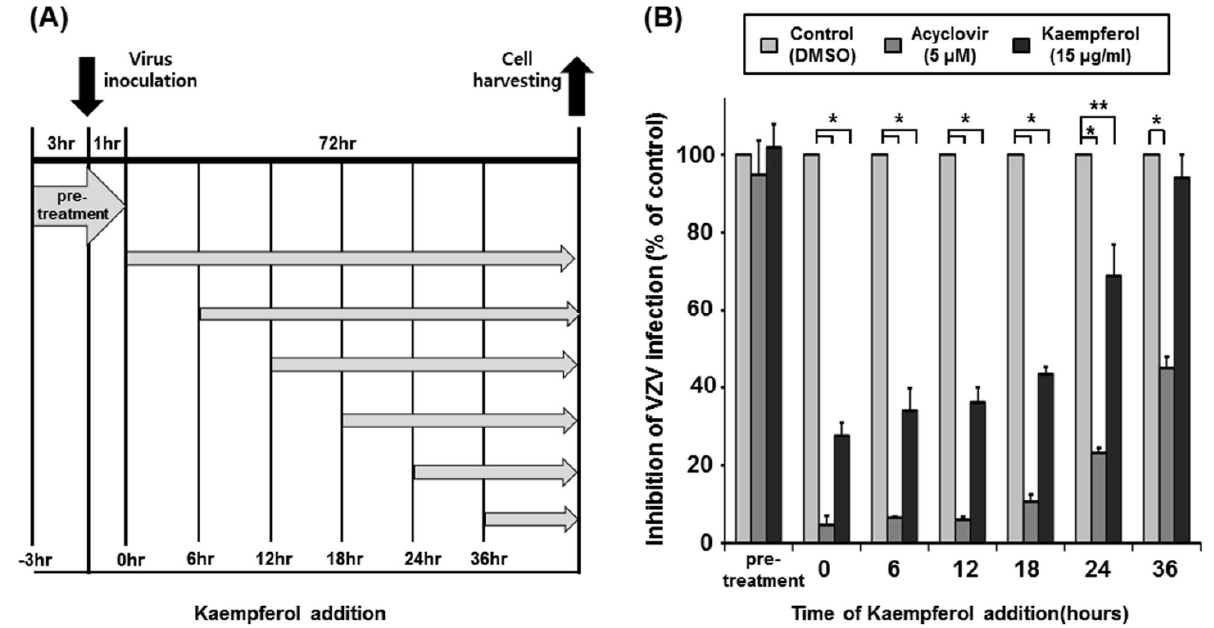
Figure 4. Time-of-drug-addition assay to identify the target of kaempferol. ( A ) Schematic diagram of the assay. ( B ) HFFs were pre-treated with kaempferol, acyclovir, or DMSO for 3 h and inoculated with VZV-YC01 at a MOI of 0.1. After virus inoculation for 1 h, drugs were removed, and HFFs were incubated for 72 h (pre-treatment). In addition, HFFs were inoculated with cell-associated VZV-YC01 at a MOI of 0.1 and treated with kaempferol (15 µg/mL), acyclovir (5 µM), or DMSO at 0, 6, 12, 18, 24, and 36 h after inoculation. Cells were harvested 72 h after inoculation, at which point total DNA was extracted and the relative amount of viral DNA was analyzed by qPCR using primers specific for open reading frame 62 (ORF62) and glyceraldehyde 3-phosphate dehydrogenase (GAPDH). Experiments were performed in triplicate and GAPDH-normalized values were expressed relative to those in cells treated with DMSO (defined as 100%). * p < 0.005, ** p < 0.05 (Student’s t -test).